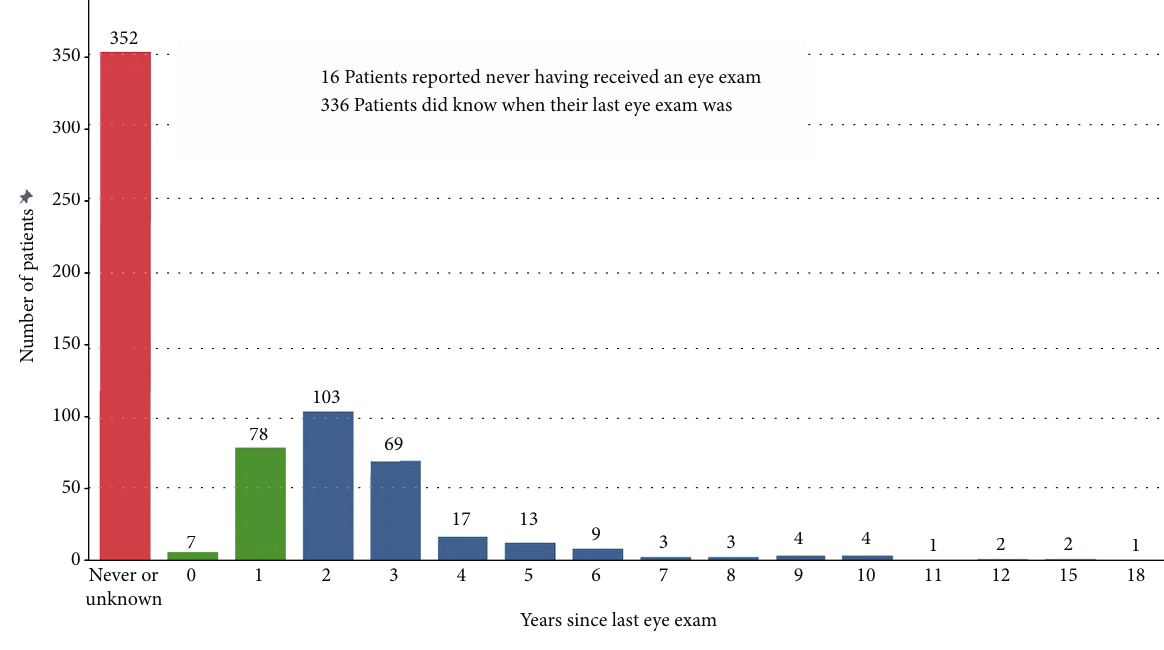
Figure 4: Bar graph depicting the number of patients by year since their last reported eye exam. Table 3: Descriptive statistics of those with interpretable images broken down by DM